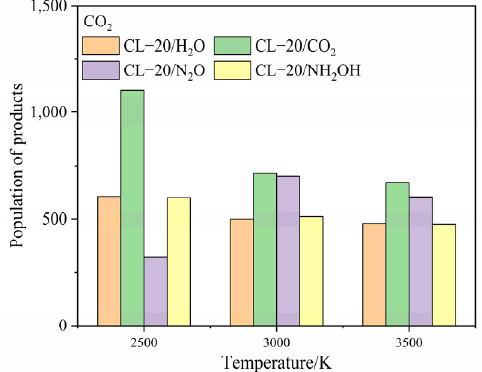
Figure 11. The population of CO 2 after the complete decomposition reaction for CL-20/H 2 O, CL-